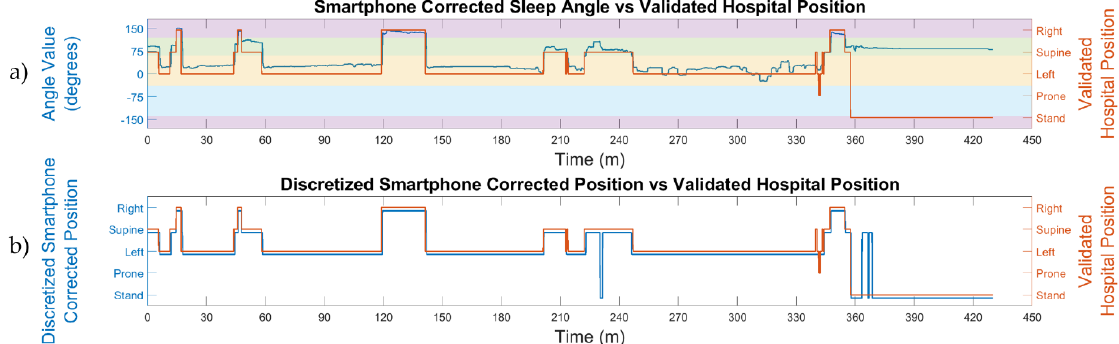
Figure 3. Comparison between the sleep position angle calculated from the smartphone accelerometry (( a ), blue line) and the discrete video-validated hospital position (( a ), orange line) for patient 14. The automatic smartphone discretized position (( b ), blue line) is obtained from the smartphone accelerometry sleep angle for the four sleep positions and compared to the video-validated hospital position (( b ), orange line). The smartphone stand position is calculated from the stand angle and shown together with the sleep positions. The color bands in the top image show the thresholds used to discretize the accelerometry sleep angle for the four different sleep positions (supine, prone, left, and right). The accelerometry angle correctly determines the movement of the patient and provides an accurate sleep position.